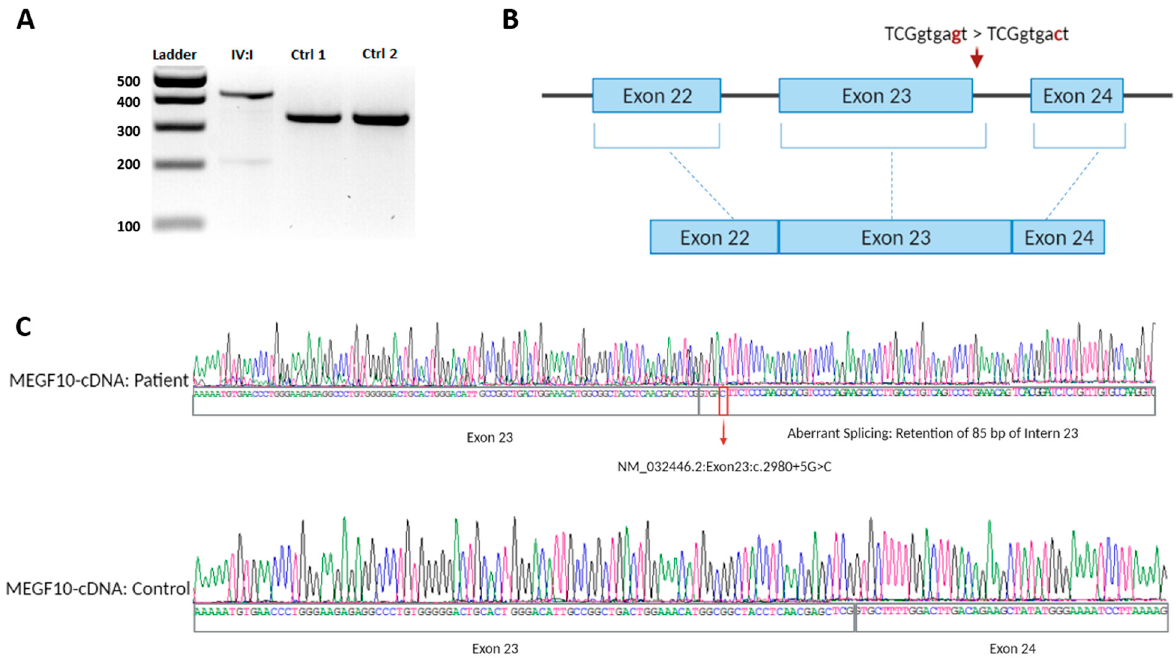
Figure 4. RT-PCR result for patient 2. RT-PCR was performed on RNA extracted from lymphocytic cell culture line from the patient 2 followed by 2% agarose gel electrophoresis. ( A ) Compared to both controls, the patient has a higher size band implicating presence of an aberrant transcript. ( B ) Illustration presents the predicted splicing effect. ( C ) A variant at the fifth nucleotide in intron 23 was found by DNA Sanger sequencing that is also indicated presence of a retained DNA (85 bp) from intron 23.